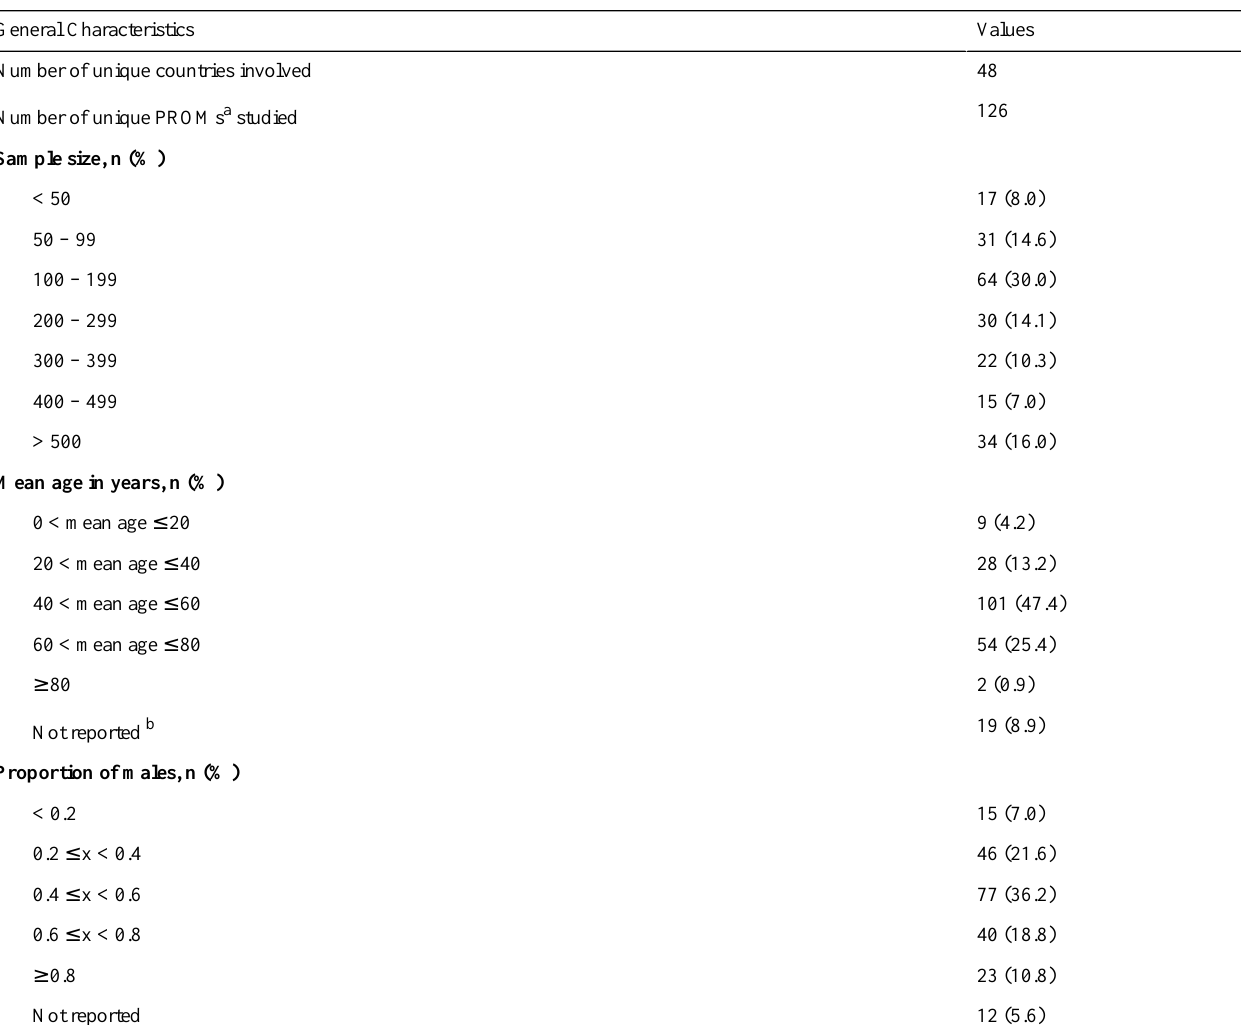
Table 1. Characteristics of studies for potential inclusion into the item bank